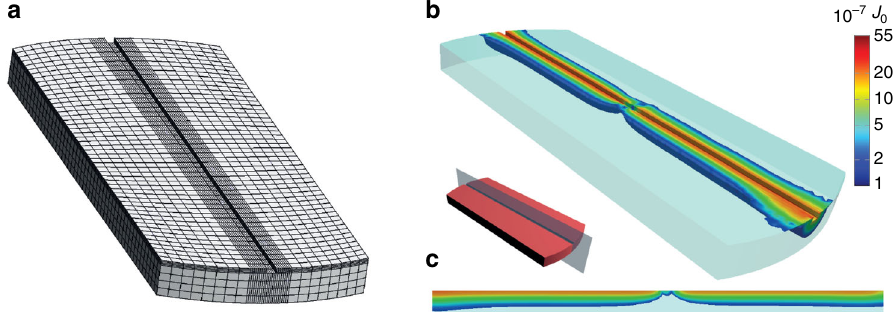
Fig. 2 Numerical simulation of the critical current. a The discretized model (or mesh) used in the numerical simulation of the critical current. Since the triplet current is mostly concentrated in the immediate vicinity of the trench, the mesh density (and hence the accuracy) is set to be higher for this region. For the same reason, the regions farthest away from the trench have been removed to reduce the calculation time. b The critical current density divided by a factor J 0 ¼ N 0 eD Δ , where N 0 is the density of states at the Fermi level, D is the diffusion constant, Δ is the superconducting gap and ξ is the 2 ξ superconducting coherence length. For clarity, currents lower than 10 − 7 J 0 are not shown. c A slice through the centre of the trench, showing how the current passes across the Co barrier in two separate channels, on either side of the vortex core